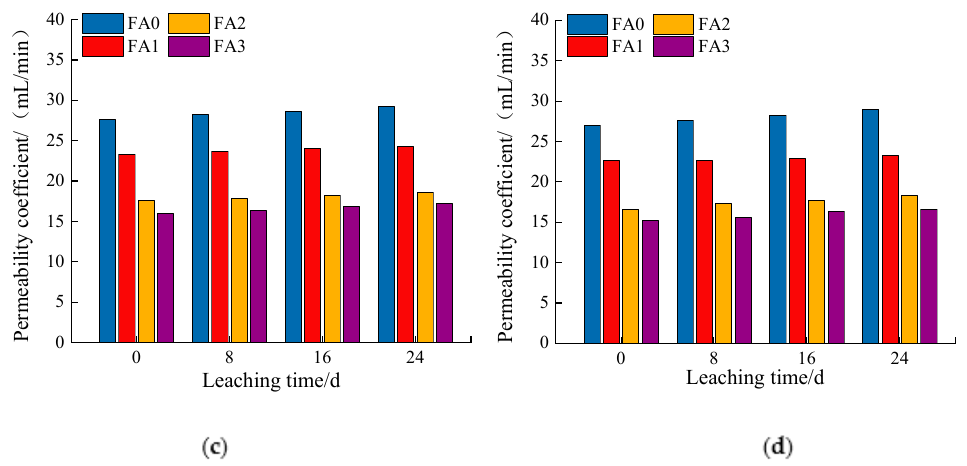
Figure 10. Change in permeability coefficient: ( a ) cement:fly ash = 1:0.1; ( b ) cement:fly ash = 1:0.2; ( c ) cement content: 4%; ( d ) cement content: 5%.